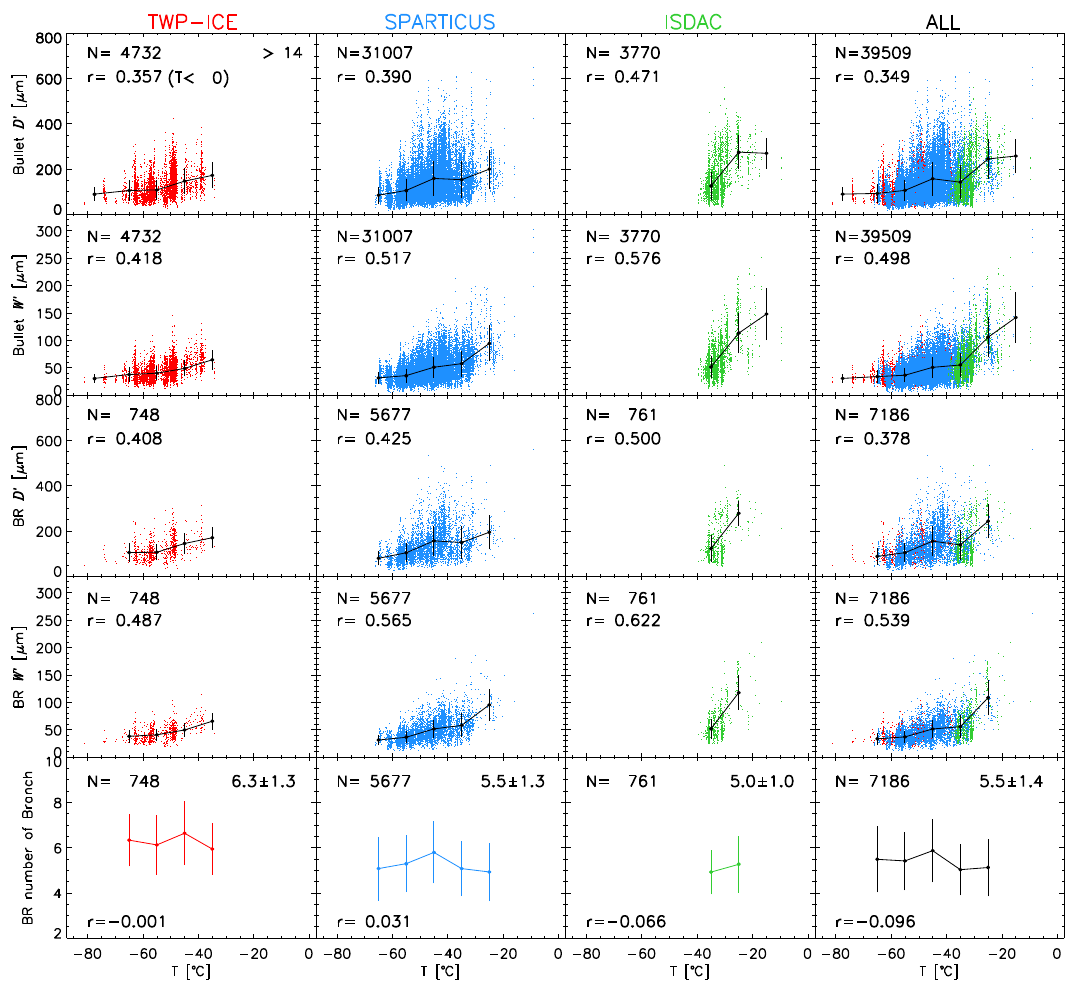
Figure 8. As in Fig. 7 except for bullets (top two rows) and bullet rosettes (BR, third and fourth rows from the top). Here, each dimension for a BR is the average of its component bullets. Mean and standard deviation of the number of bullet rosettes are shown in the bottom